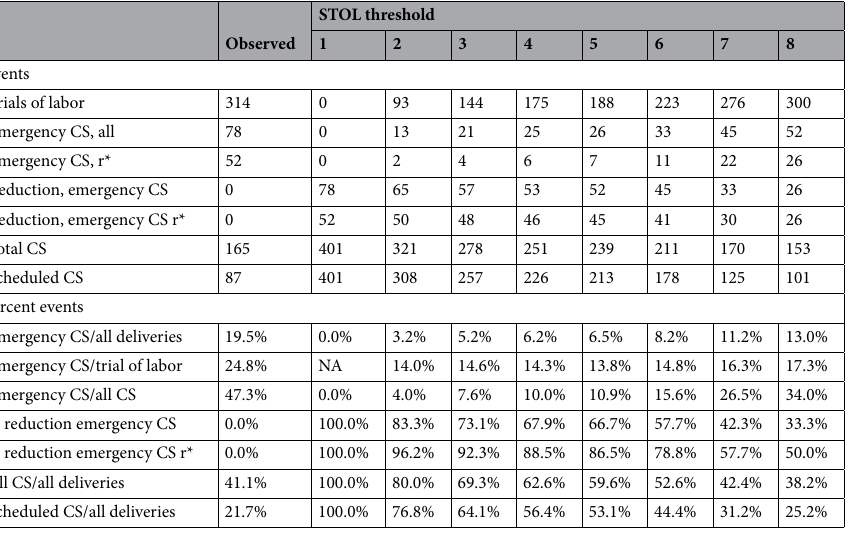
Table 3. Sensitivity analysis of PREDIBIRTH score cutoffs vs. outcomes. CS cesarean section, r* related to cephalopelvic disproportion, STOL simulated trial of